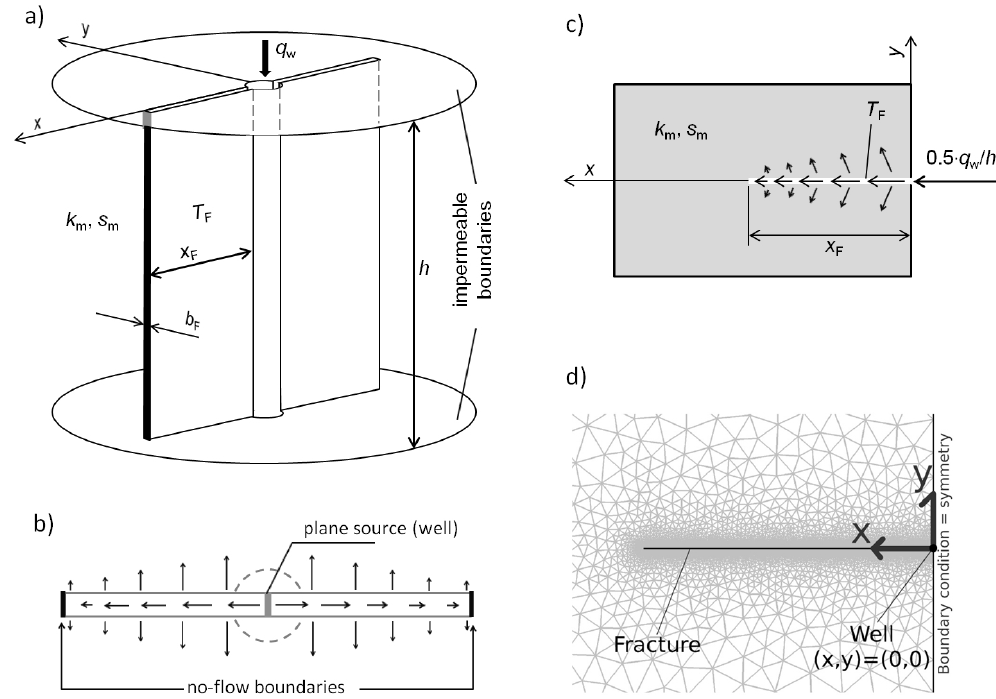
Fig. 1. Model geometry and realized mesh for